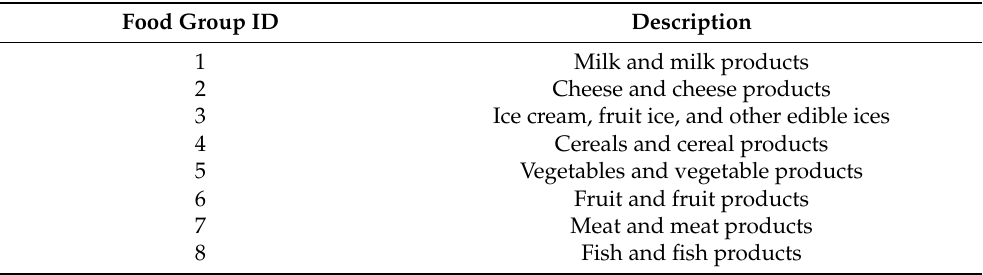
Table 2. Food group description considered for modeling of vitamin D fortification. Each food group has a different number of food